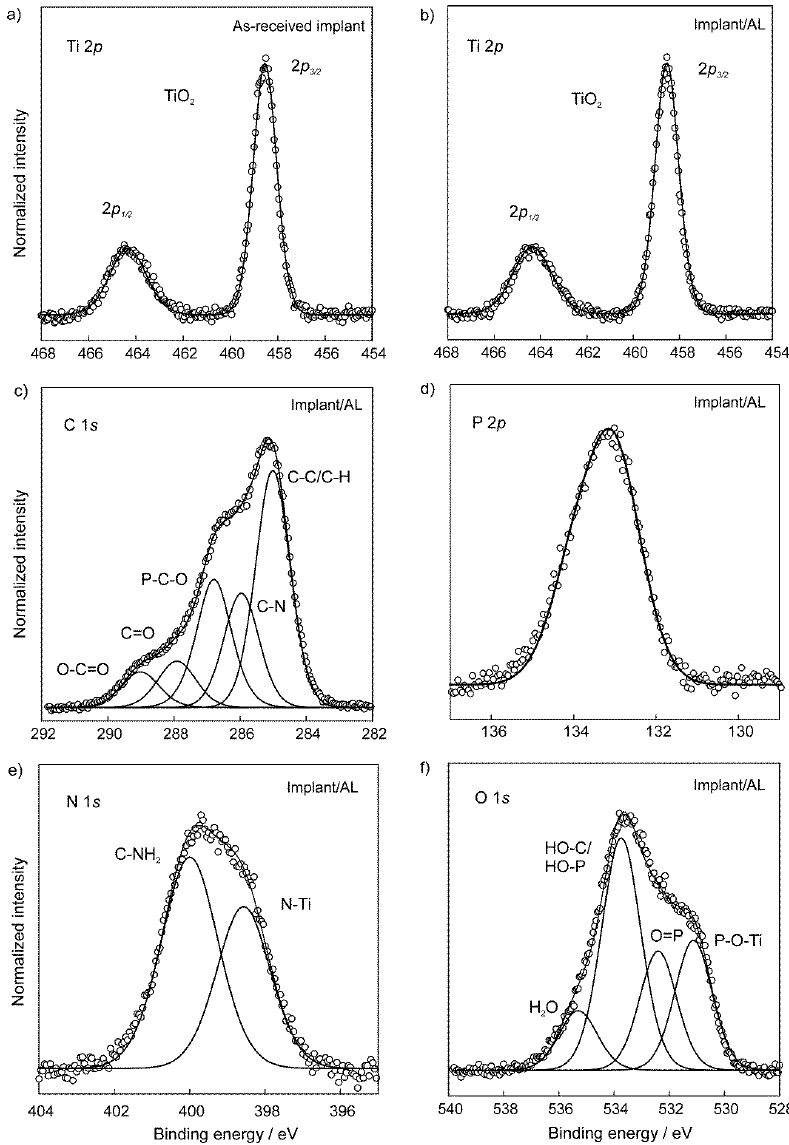
Figure 3. High-resolution XPS spectra ( a ) around Ti 2p core-level of the as-received implant; ( b ) Ti 2 p; ( c ) C 1 s ; ( d ) P 2 p ; ( e ) N 1 s ; ( f ) O 1 s core-levels of the alendronate-modified implant surface (Implant/AL).